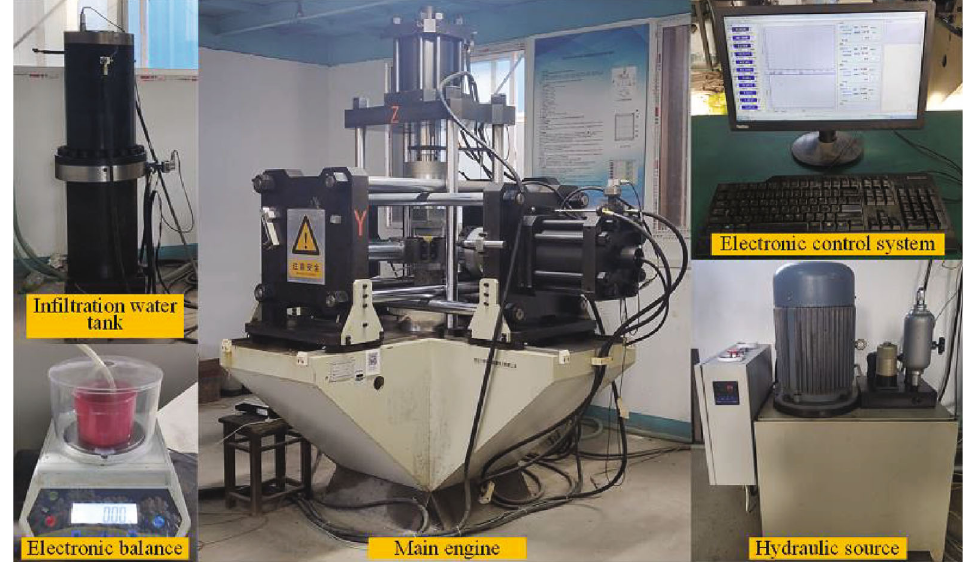
Figure 3: True triaxial testing system for determining rock fracture